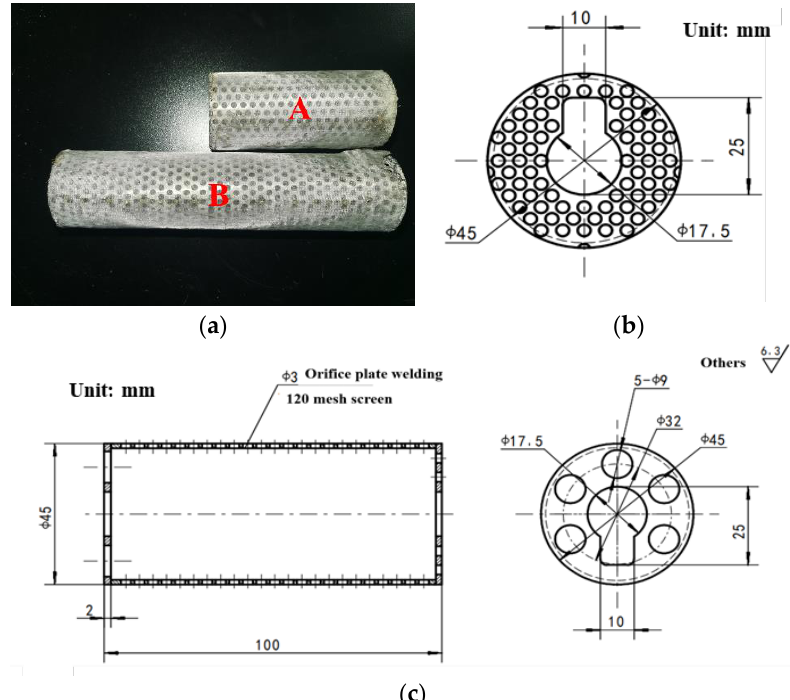
Figure 5. ( a ) Real shot of gravel packing device, A: Gravel-packed barrels for vertical wells; B: Gravel packing barrel for radial well; ( b ) right side view of mechanical drawing of gravel packing device ( c ) front and left side view of mechanical drawing of gravel packing device.